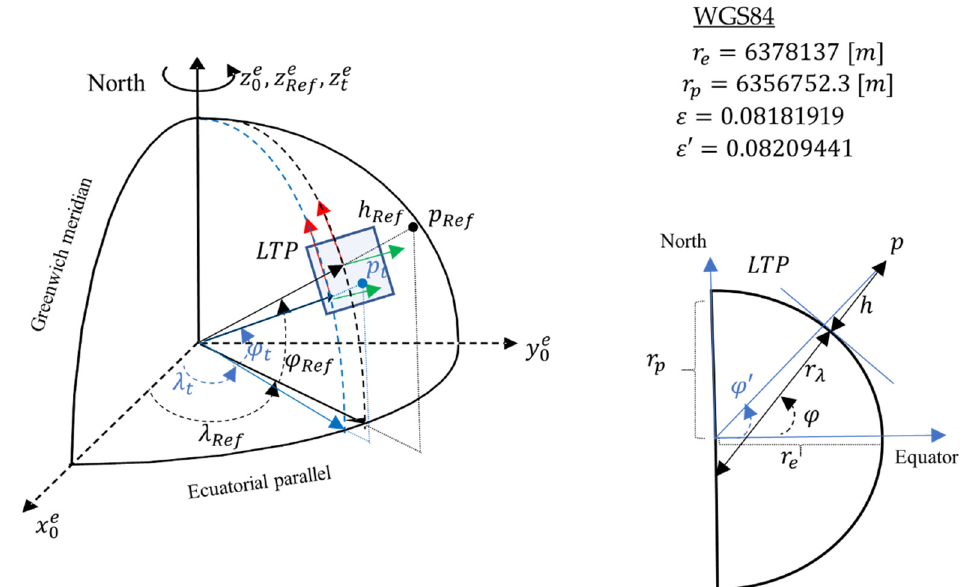
Figure 2. LTP, ECEF, and WGS84 reference systems and geometric relationships.